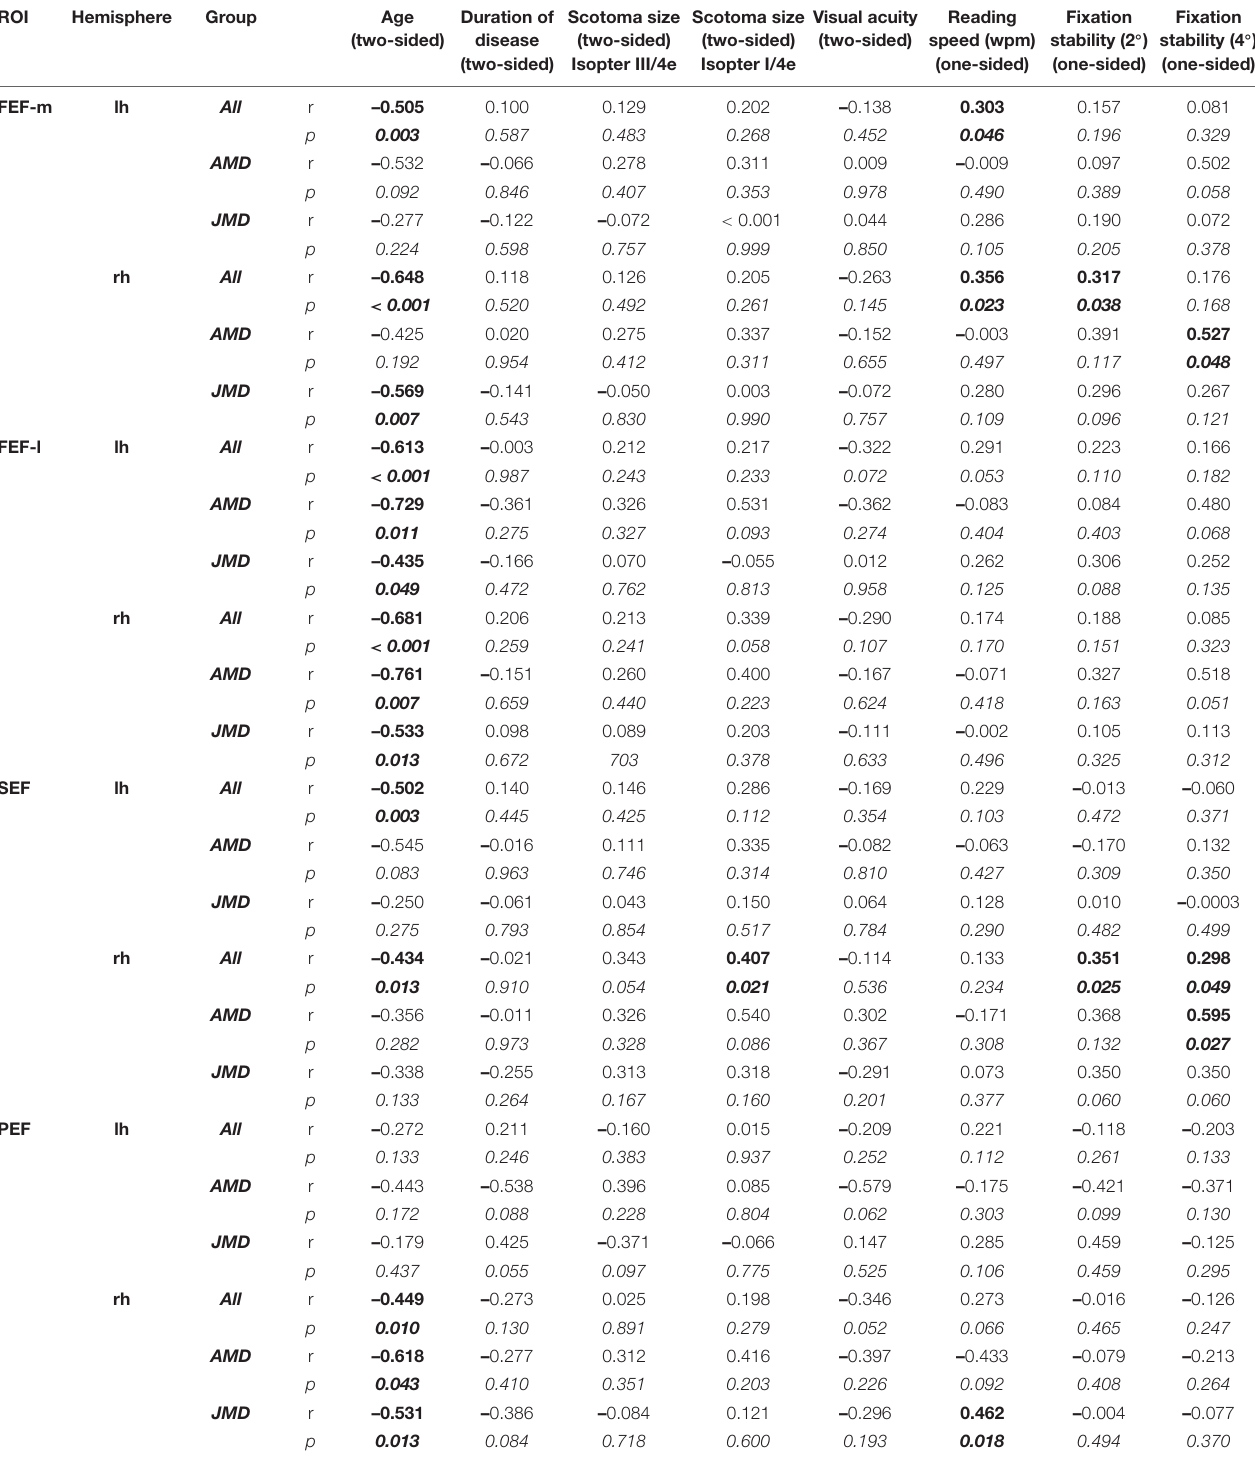
Fixation stability (4 ◦ )